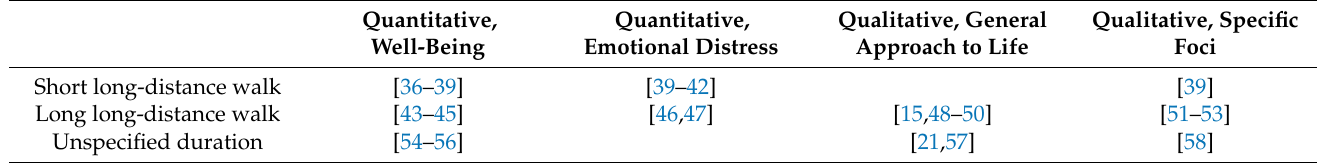
Table 2. Overview of included studies based on notions of mental health and definition of long-distance walk. Quantitative, Quantitative, Well-Being Emotional